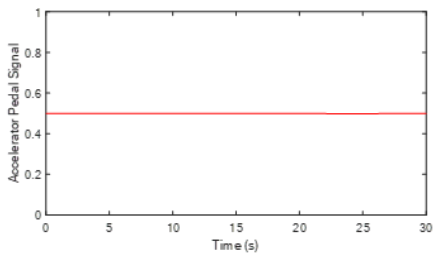
Figure 19. Acceleration pedal.